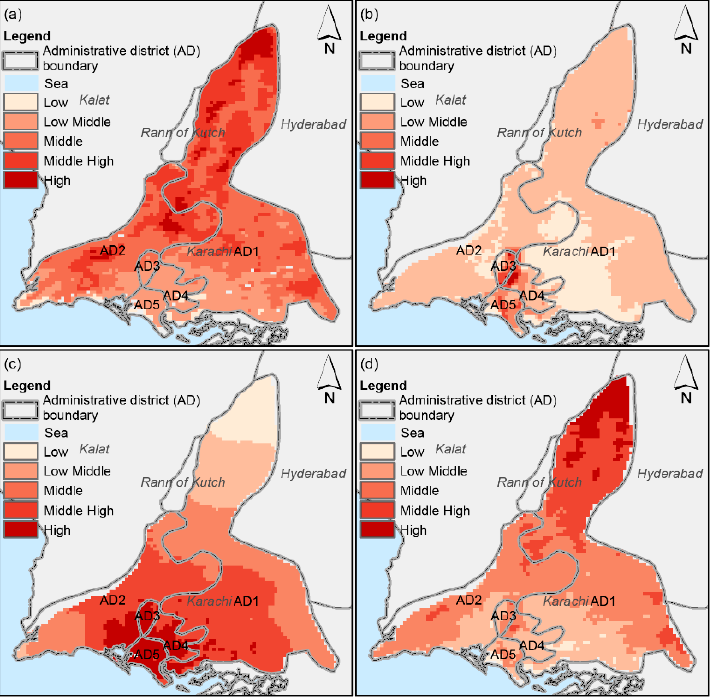
Figure 4. Heat health ( a ) exposure, B1 ( b ) sensitivity, B2 ( c ) adaptability, B3 ( d ) vulnerability, A in each administrative district (AD) of Karachi, including Malir (AD1), Karachi West (AD2), Karachi Central (AD3), Karachi East (AD4) and Karachi South (AD5).